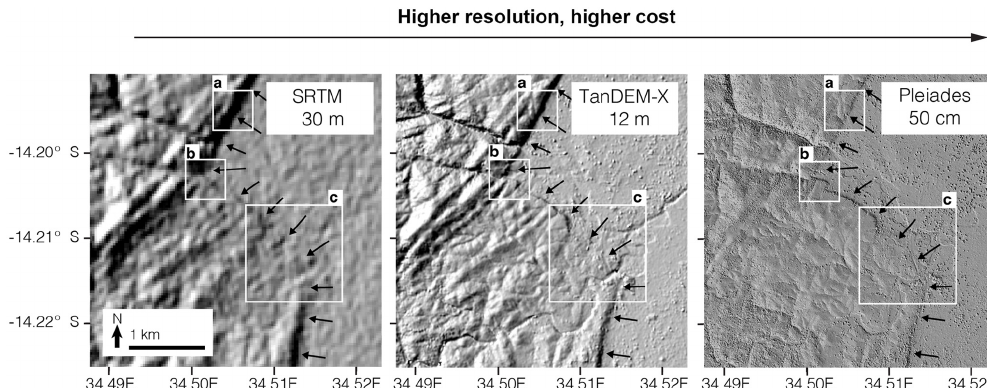
Figure 6. Bilila–Mtakataka fault scarp hillshade DEM examples using SRTM 30m, TanDEM-X 12m and Pleiades 5m DEMs. The black arrows represent the fault scarp trace picked using each DEM. Box A represents the typical trend of the Bilila–Mtakataka fault scarp, boxes B and C show changes in variation in scarp trend.